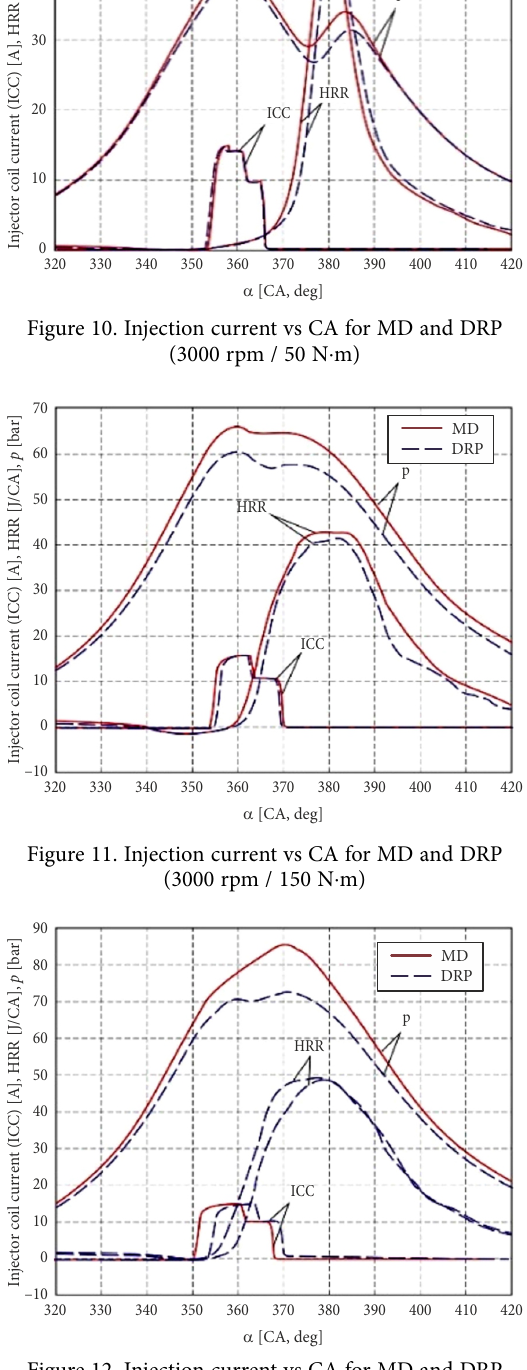
Figure 9. Injection current vs CA for MD and DRP